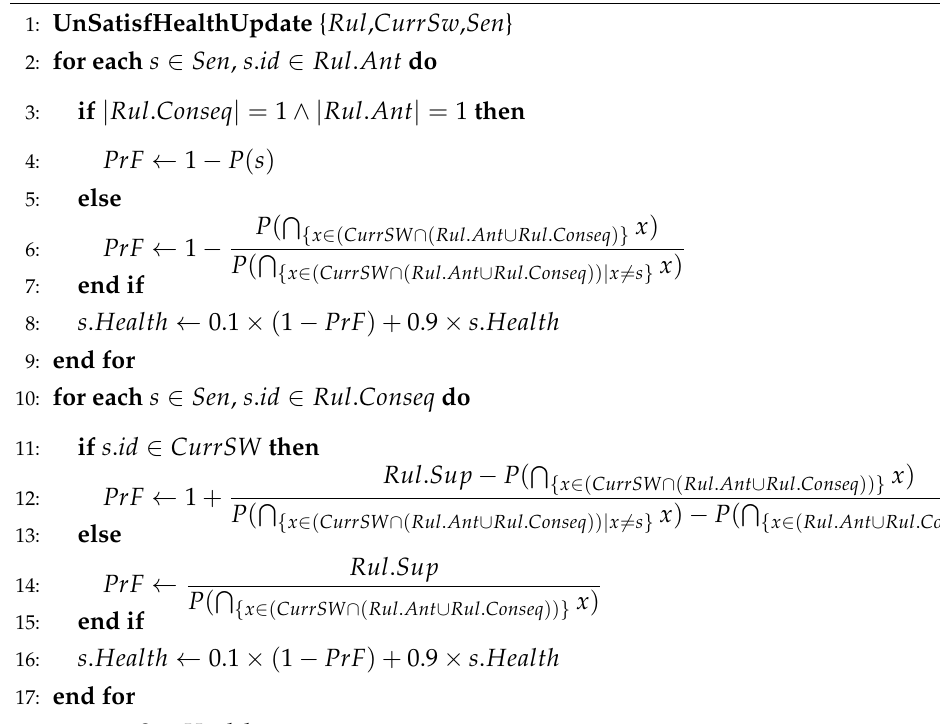
Algorithm A3 Health Status Update due to Rule